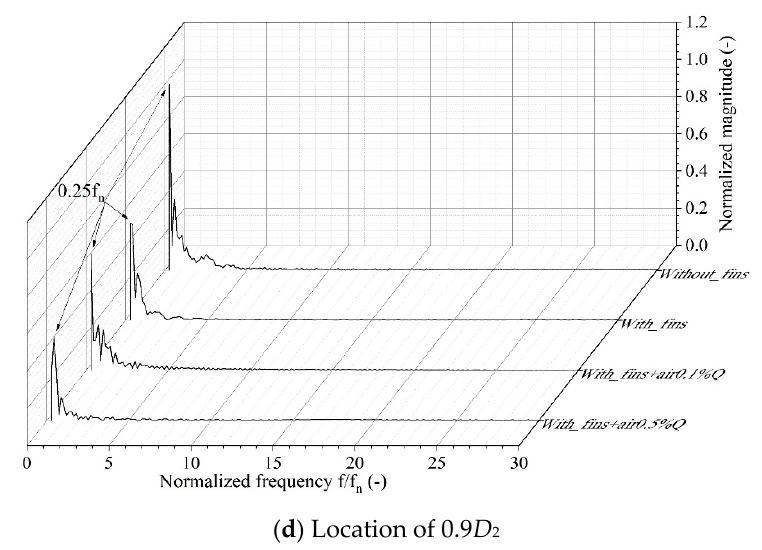
Figure 12. Normalized unsteady pressure characteristics along the flow direction in the DT.